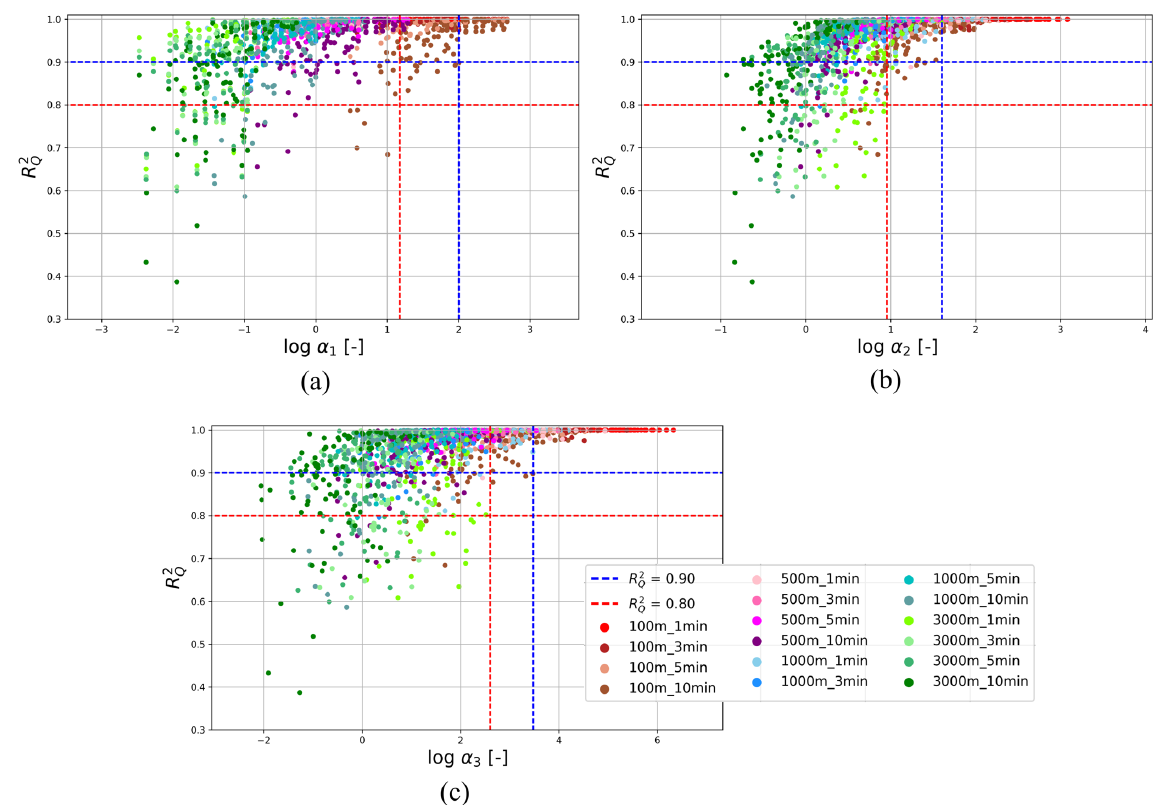
Figure 12. Logarithmic plots of R 2 as a function of (a) α 1 , (b) α 2 and (c) α 3 . Different colours indicate different Q